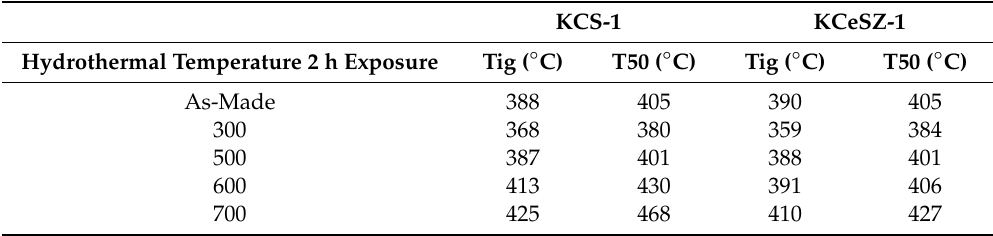
Table 2. T IG and T 50 of KCS-1 and KCeSZ-1 coatings on cordierite after 2 h hydrothermal exposure at various